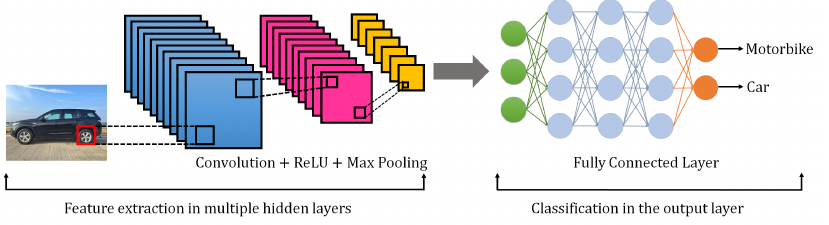
Figure 8. A general architecture of the Convolutional Neural